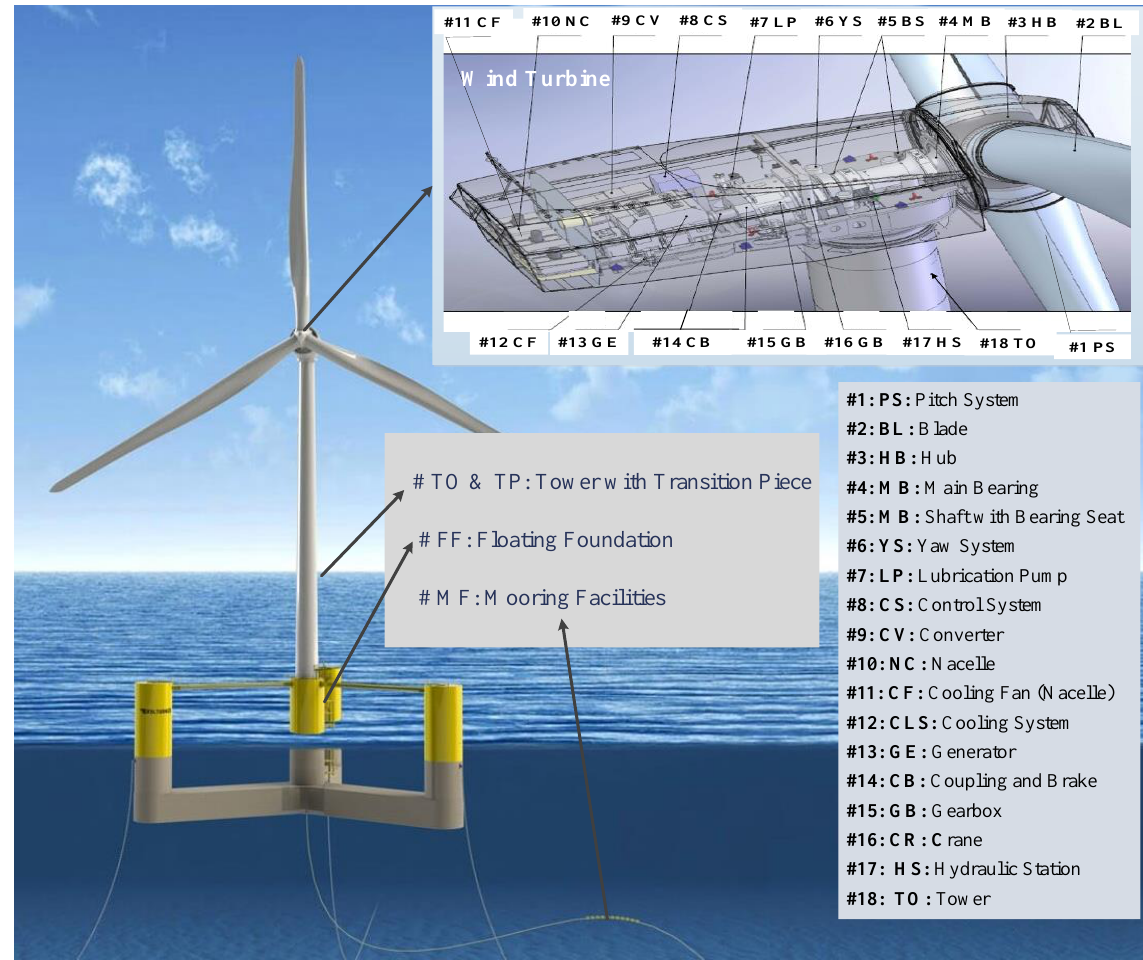
Figure 1. Typical configuration of floating offshore wind turbines.